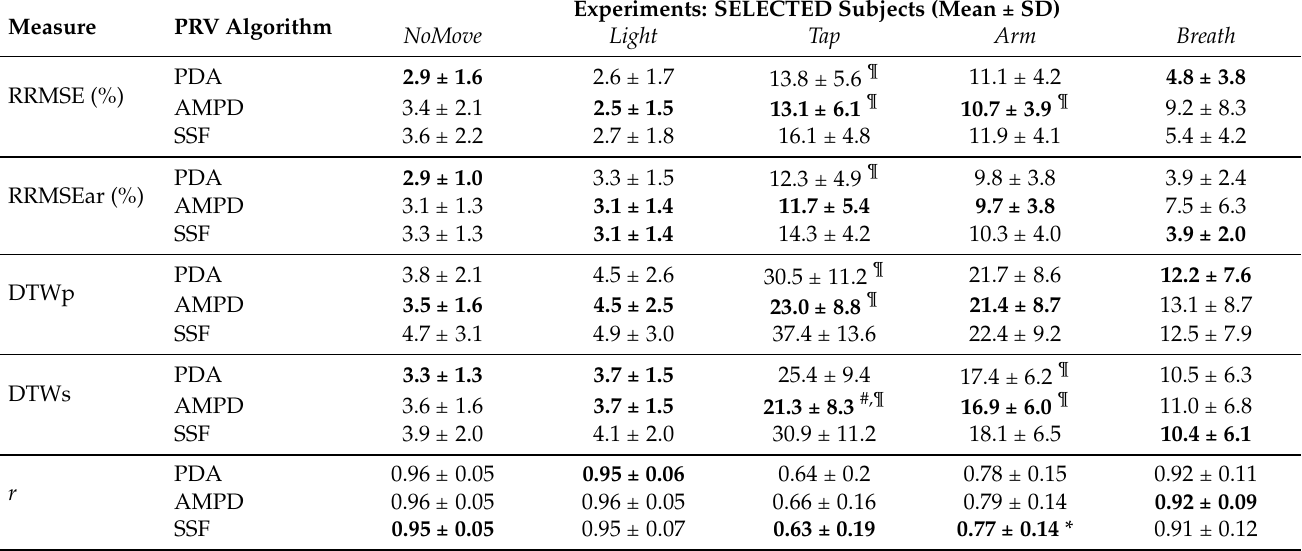
Table 3. Similarity measures of HRVs and PRVs obtained from simultaneous ECG and PPG (averaged over SELECTED subjects): RRMSE—relative RMSE before AR modeling, RRMSEar—relative RMSE after AR modeling, DTWp—Dynamic Time Warping before entire post-processing, DTWs—Dynamic Time Warping after outliers correction, r —Pearson’s correlation coefficient after entire post-processing. The symbols #, *, or ¶ indicate that a given value is statistically smaller than for PDA, AMPD, and SSF, respectively, verified with the Student’s t -test at the 5% significance